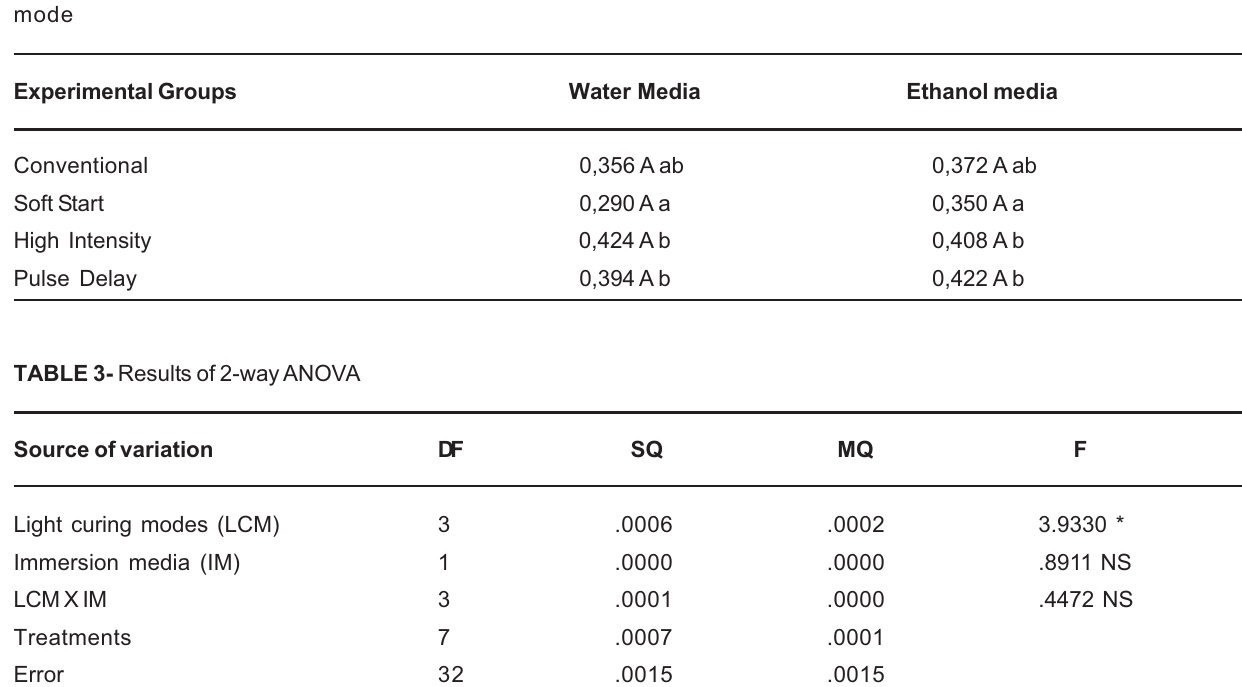
TABLE 2- Results of staining means for the experimental groups (light curing modes) (µg/mL). Means with the same lowercase letter were not statistically different (p<0.05) for comparisons between the same medium. Means with the same uppercase letter were not statistically significant different (p<0.05) for comparisons between the same polymerization